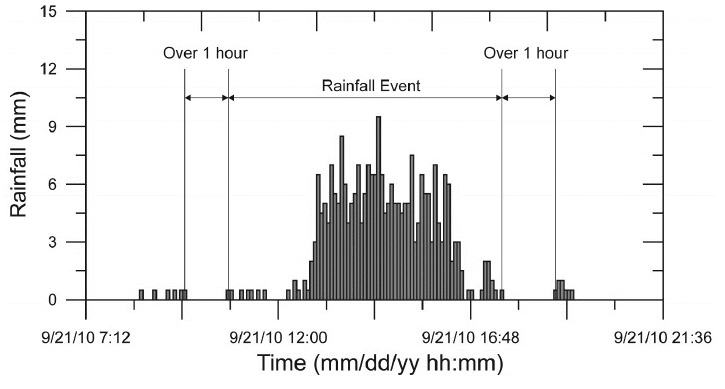
Figure 3. Separation condition for independent rainfall